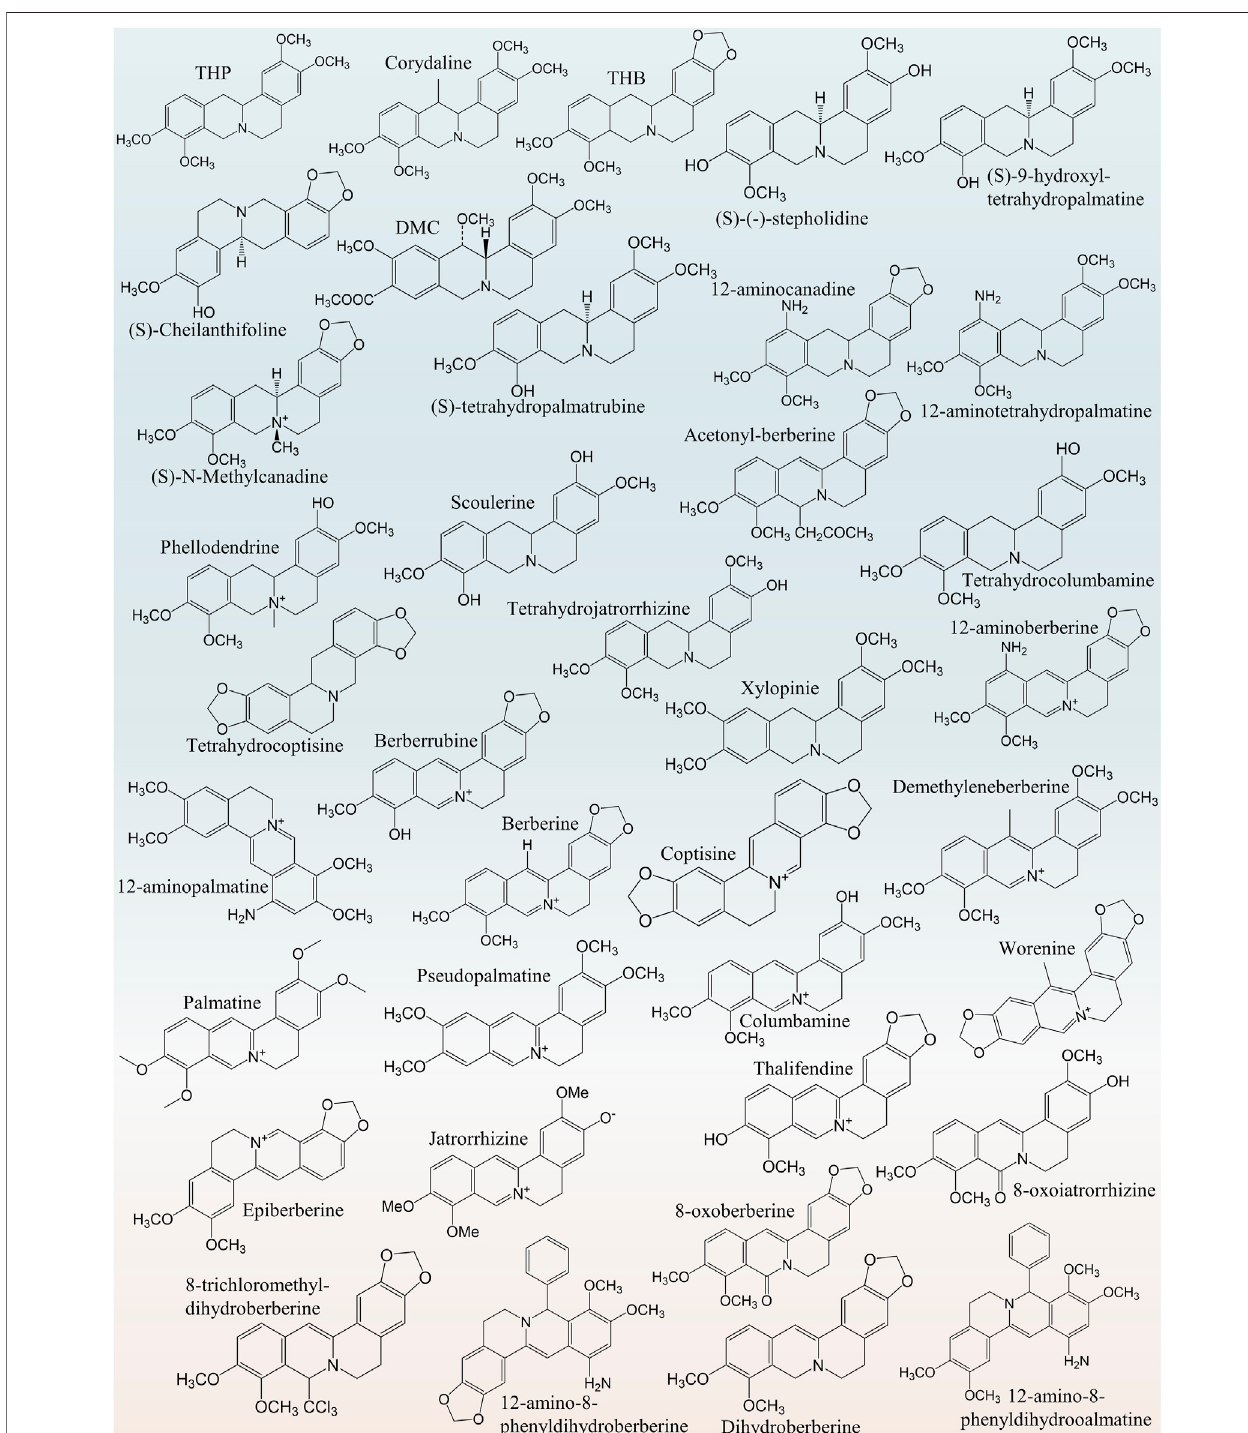
FIGURE 2 | Chemical structural formulae of THP and its main related derivatives.